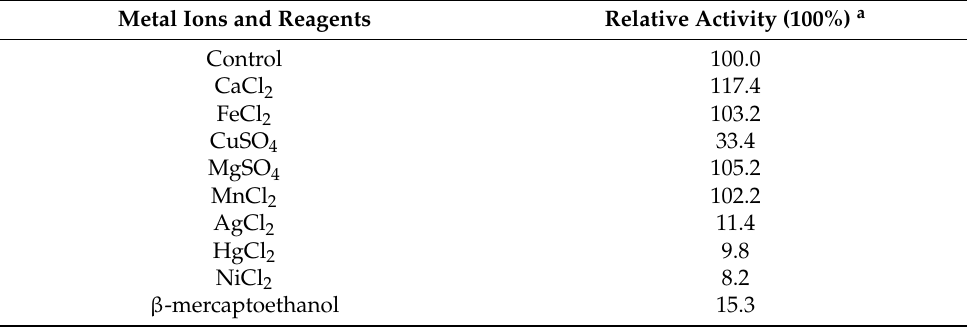
Table 2. Effects of some metal ions and reagents on purified